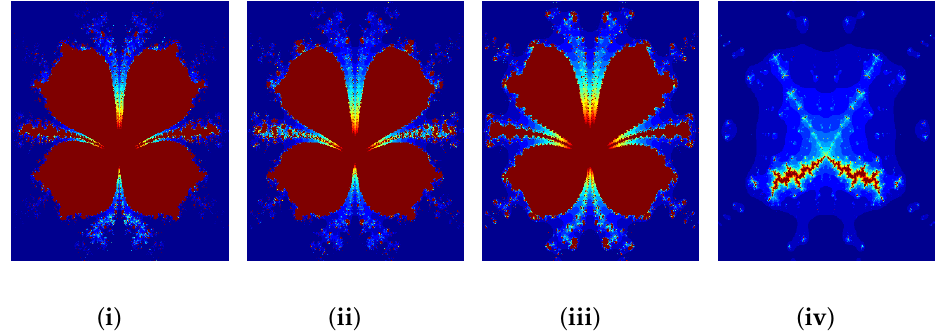
Figure 14. Quintic Julia sets in ( i ) Noor-orbit; ( ii ) Ishikawa-orbit; ( iii ) Mann-orbit; ( iv ) Picard-orbit.